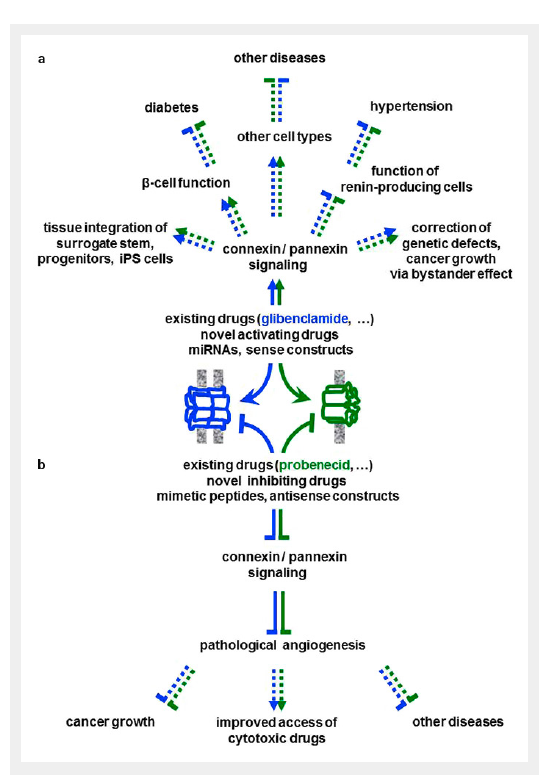
Figure 5 The translational perspectives. (a) The stimulation (arrows) of junctional and non-junctional channels (e.g. those formed by Cx36 and Panx2) is expected (dotted lines) to reproduce in humans the beneficial effects of connexin (blue) and pannexin (green) signalling observed in rodents. In turn, increasing the function of pancreatic β- cells is expected to improve the treatment of type 1 or type 2 diabetes. Increased connexin and pannexin signalling is also expected to foster the integration in the host tissues of surrogate cells designed for cell replacement therapies. (b) Conversely, the inhibition (flat-end lines) of selected connexin species (e.g. Cx40) is expected to prevent the over-stimulation of the renin-producing cells, thus contributing to mitigate several forms of hypertension. The specific down-regulation of Cx40 is also expected to prevent excessive angiogenesis, while preserving a normal vessel wall and function, thus improving the efficiency of current cytotoxic therapies. This combined approach could reduce the growth of some cancer forms and the development of other diseases due to excessive